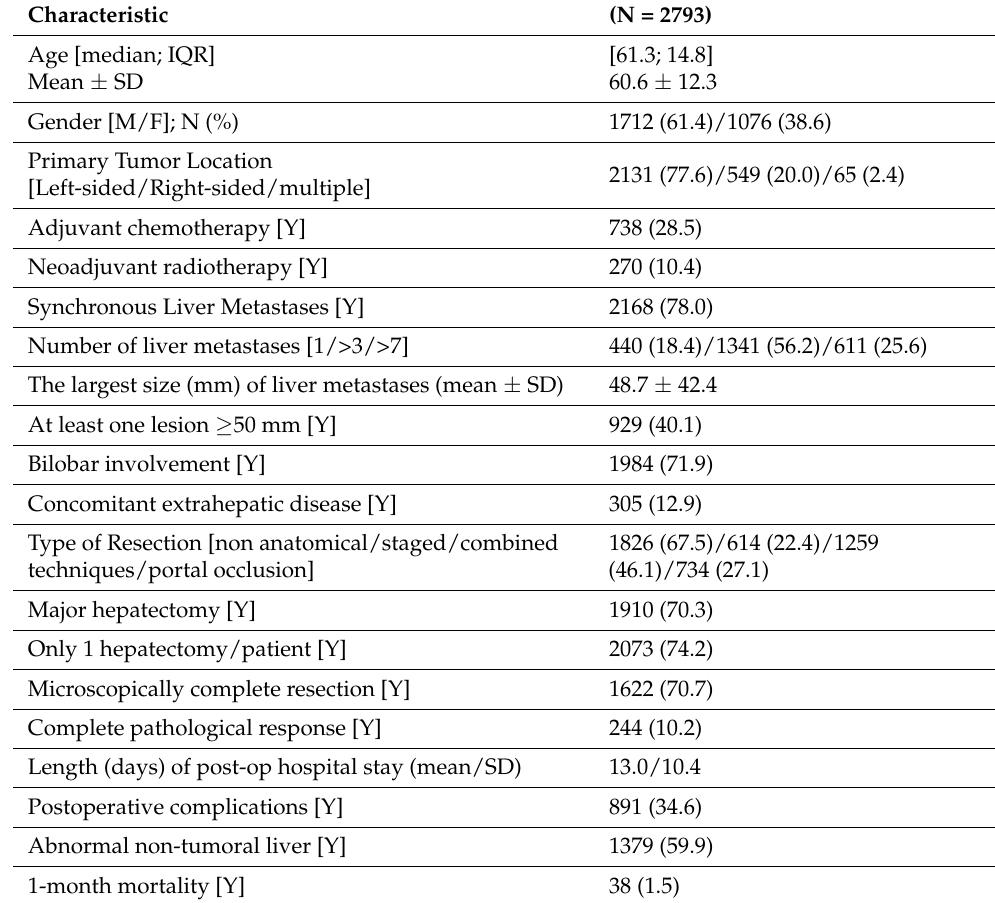
Table 1. Main demographical, clinical and surgical characteristics of the study population (N = 2793) and of the PO-SACT features and